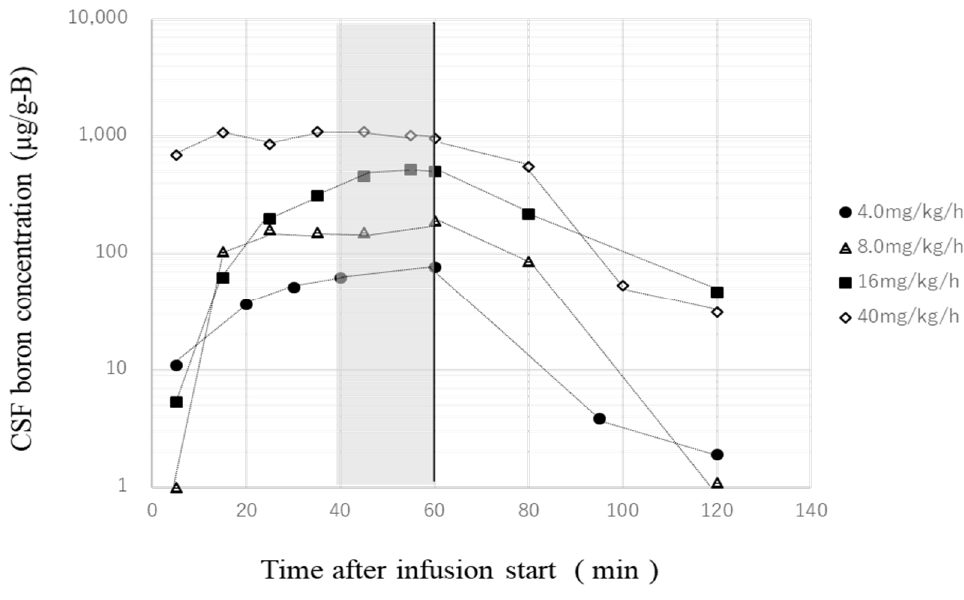
Figure 2. Boron concentration–time profile in CSF.